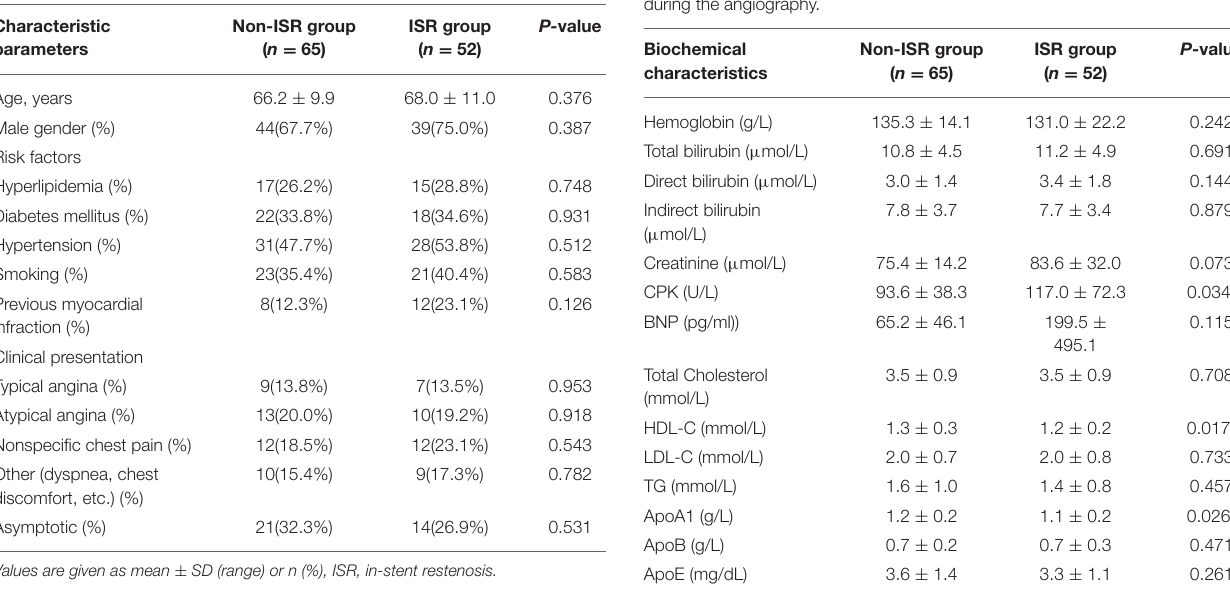
TABLE 1 | Baseline characteristics of the patients included. TABLE 2 | Biochemical characteristics of ISR and non-ISR patients evaluated